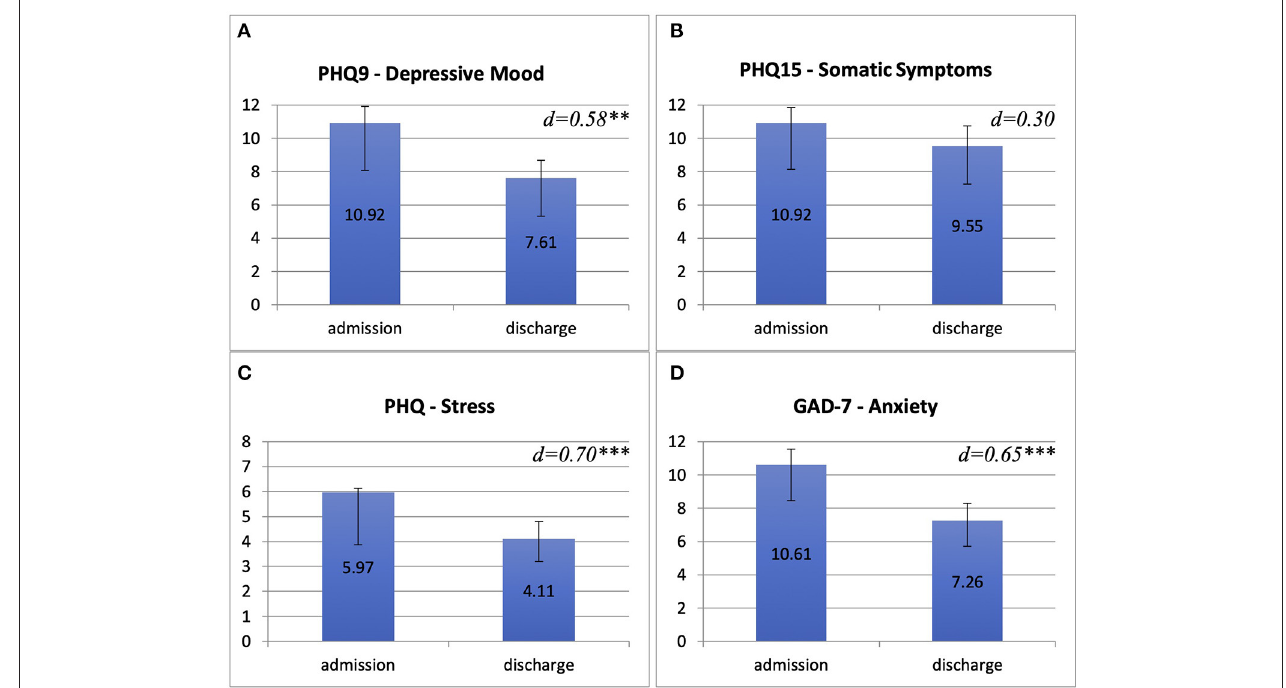
FIGURE 2 | NIPA treatment outcomes compared between admission and discharge on the four symptom scales assessed. We compared means (Y-axis) of Patient Health Questionnaire for depressive mood [PHQ9, (A) ], Patient Health Questionnaire for somatic symptoms [PHQ15, (B) ], PHQ-stress-scale (C) and Generalized Anxiety Disorder Scale-7 [GAD-7, (D) ].